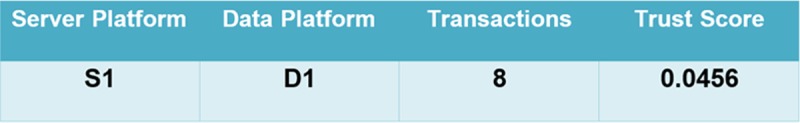
Trust Lookup Table.